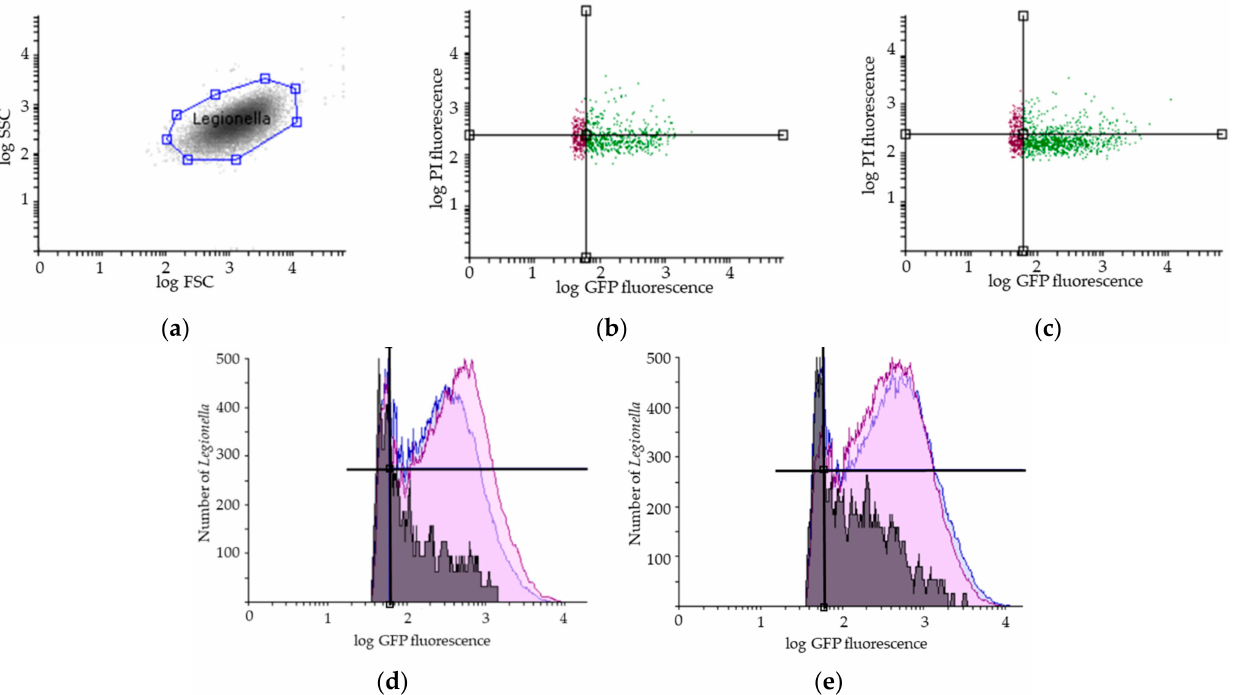
Figure 2. Representative results of flow cytometry assay (FCA). ( a ) Legionella pneumophila population gating, SSC (Side Scatter), FSC (Forward Scatter); Viability FCA profiles of Legionella pneumophila in bioaerosols after showering with ( b ) one representative STA showerhead and ( c ) one ECO show- erhead (VC: GFP+/PI − ; VBNC: GFP+/PI+; DC: GFP − /PI+); Overlays of the number of Legionella pneumophila ( y -axis) in the reservoir (in blue), in the bag (in purple) and in the aerosols collected with the Coriolis (in grey) as a function of GFP fluorescence ( x -axis) for ( d ) one representative STA and ( e ) one ECO showerhead analysis. GFP: Green Fluorescent Protein; PI: Propidium Iodide. The black lines indicate the thresholds for the fluorescence signal considered